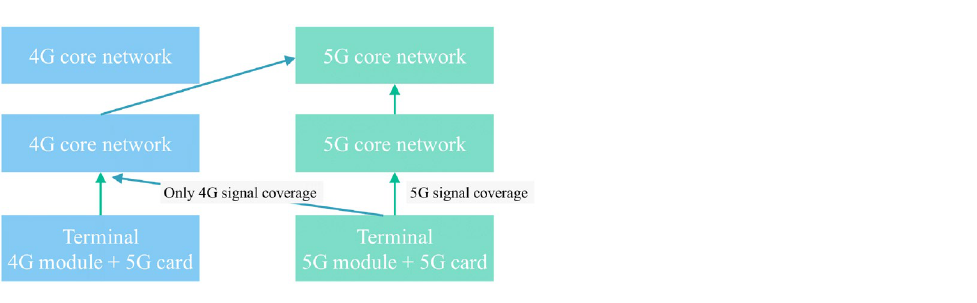
Figure 13. A 5G network fallback 4G network